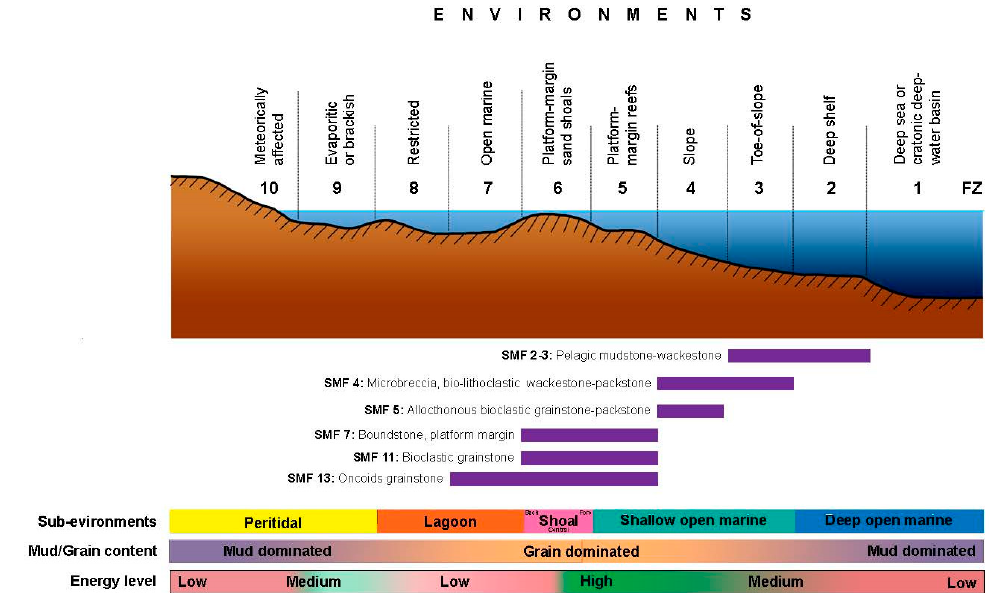
Figure 7. Depositional distribution model in the Ionian zone. The sedimentary changes display good correlation with the energy level of environments and facies changes.